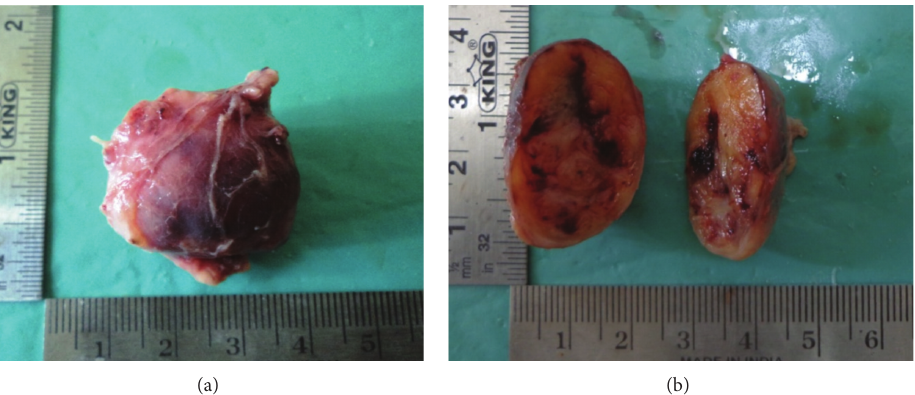
Figure 5: (a) Macroscopic picture of well-encapsulated mass measuring 3.5 cm-4 cm-3cm. (b) Cut surface of specimen shows areas of cystic degeneration inside surrounded by solid area.